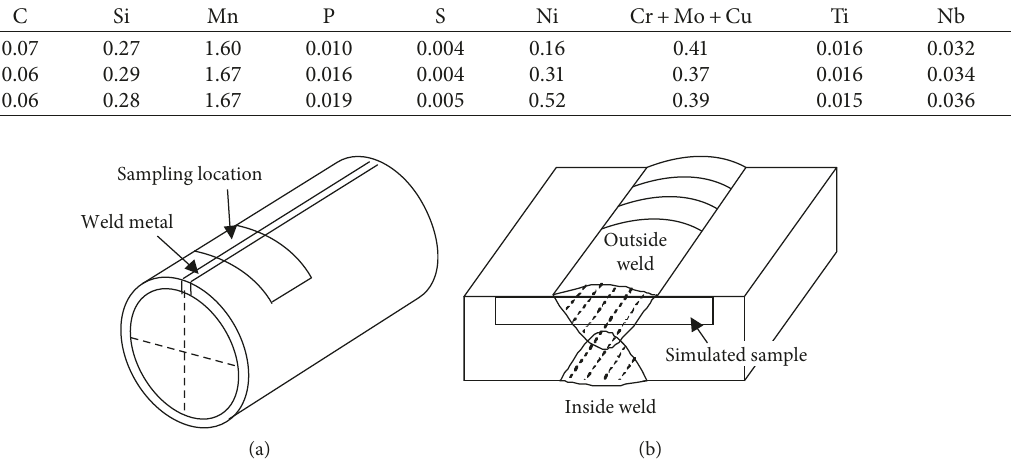
Figure 1: Sketch illustration of the sampling locations cut from the (a) welded pipe and (b) the weld metal.